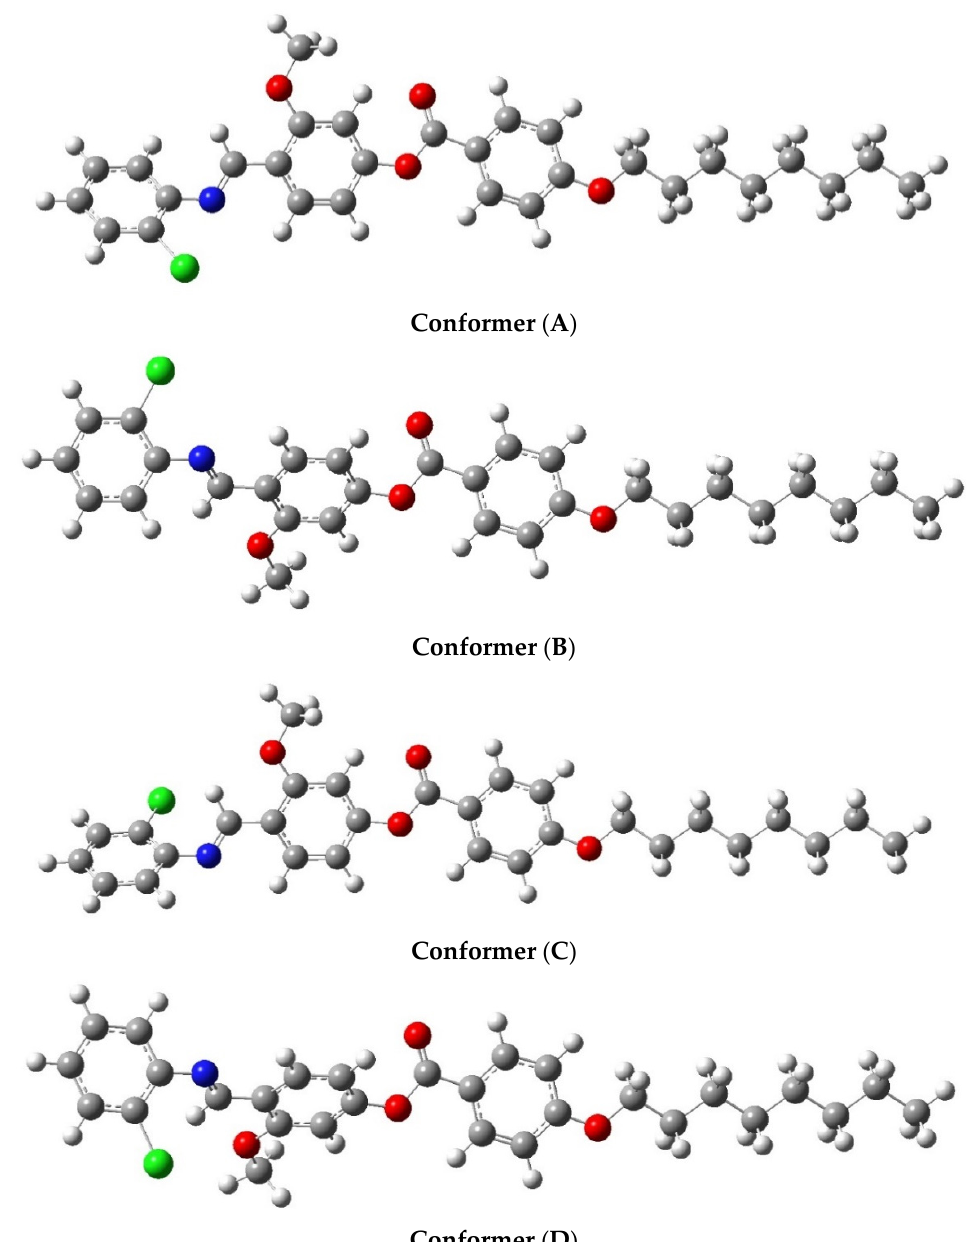
Figure 7. Possible configurations ( A , B , C and D ) for I8 derivative.